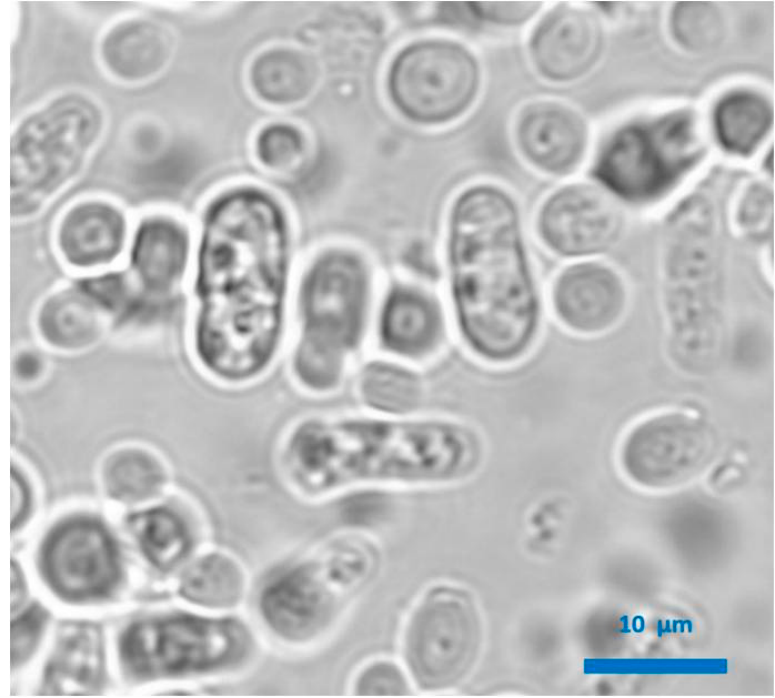
Figure 2. Microscopic observation of a wine produced with combined Lachancea thermotolerans and Schizosaccharomyces pombe alcoholic fermentation. S. pombe cells are rectangular, while L. thermotolerans cells are spherical.